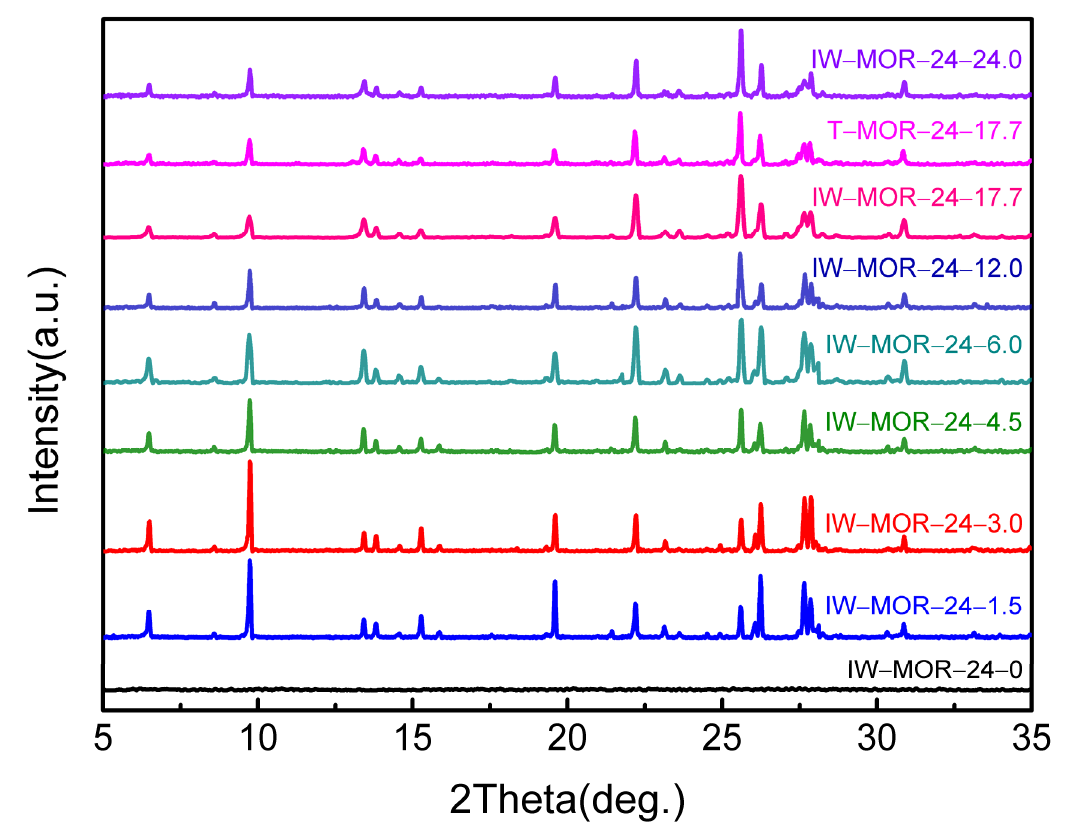
Figure 2. XRD patterns of IW–MOR–24 samples synthesized with a different molar ratio to H 2 O/SiO 2 .